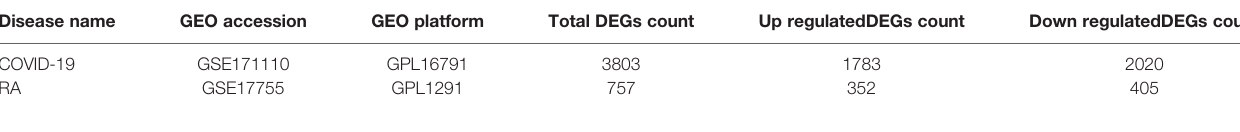
TABLE 1 | Overview of datasets with their geo-features and quantitative measurements in this analysis. Disease